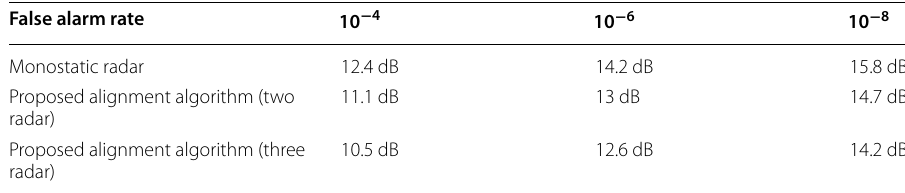
Table 2 The SNRs required for the same detection probability ( 90% )